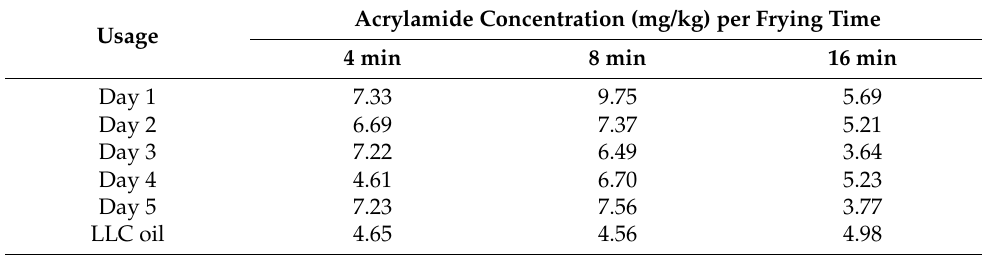
Table 3. LC-MS values for acrylamide concentration (mg/kg) per frying time from French